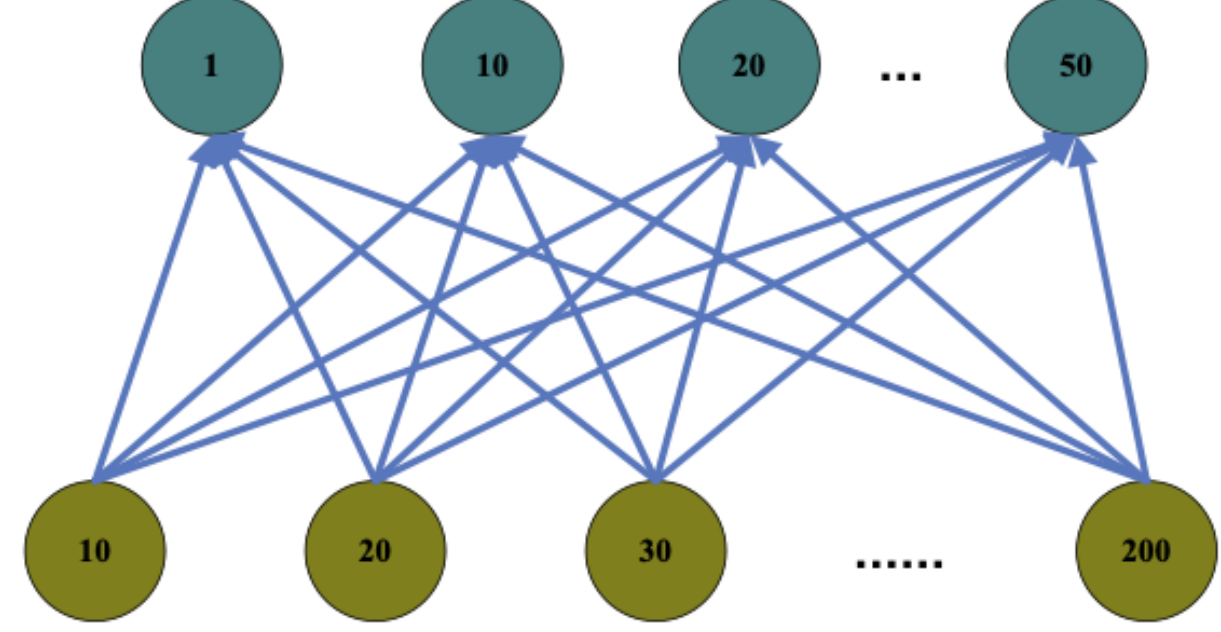
Figure 2. The combination of two levels of features used in our